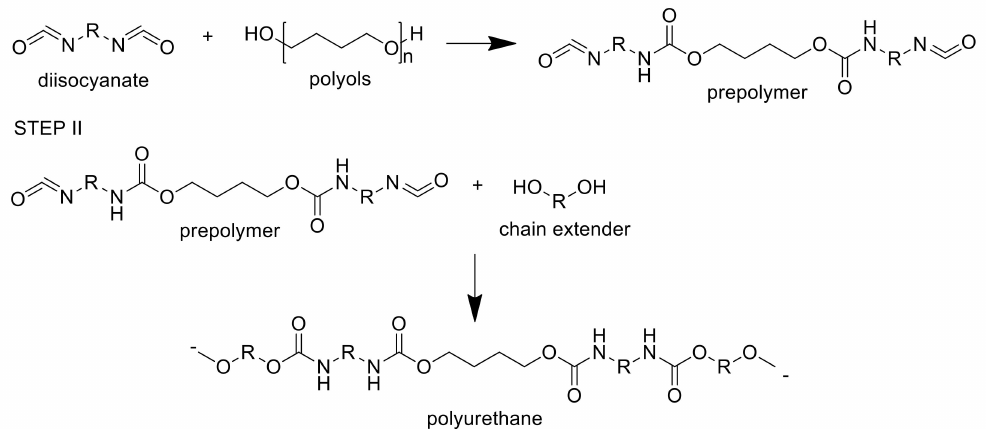
Figure 1. Traditional PU synthesis by a two-stage process using diisocyanate, polyol, and a low molecular weight chain extender